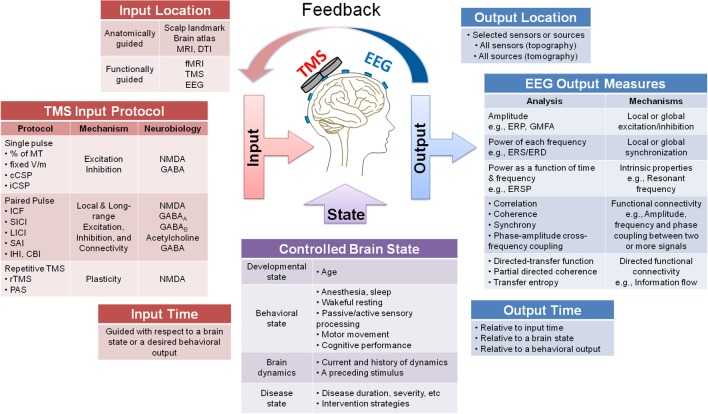
A system diagram guiding the design of TMS-EEG studies. The figure presents a system diagram of three main types of parameters that can be selected when designing a TMS-EEG experiment: TMS input parameters (location, protocol, and time), EEG output parameters (location, measures, and time), and brain state parameters (developmental, behavioral, dynamical, and disease states). Several possible choices are listed for each parameter and where applicable mechanism or neurobiology associated with each parameter is specified (e.g., for TMS input protocol and EEG output measures). The figure also depicts the possibility of using the EEG output parameters to guide the TMS input parameters, either offline or through online feedback systems.